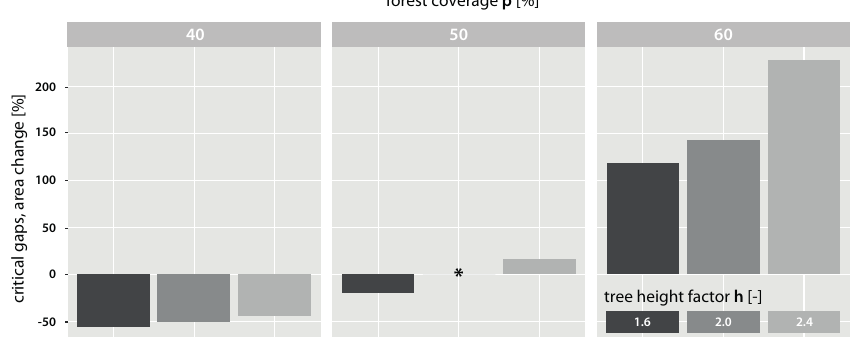
Figure 7. Sensitivity of the delineated area of effective forest on the parameters forest coverage and tree height factor. Area change is expressed as the percent change in relation to the BASE parametrization of effective forests, h = 2 and p = 50%